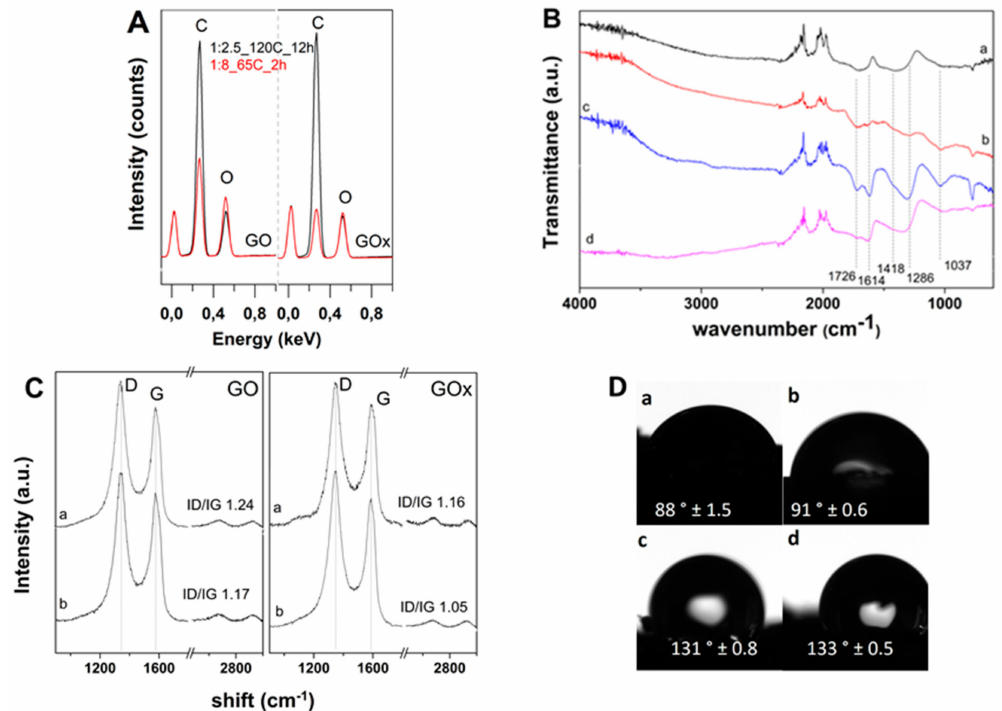
Figure 4. ( A ) EDS spectra of aerogels from GO and GOx dispersions; ( B ) FTIR spectra of aerogels from GO and GOx at 1:8_65 ◦ C_4 h (a and b), GOx at 1:2.5_4 h at 65 ◦ C and 120 ◦ C (c and d); ( C ) Raman spectra of aerogels from GO and GOx at 1:8_65 ◦ C_2 h (a) and 1:2.5_120 ◦ C_12 h (b); ( D ) Average contact angle of GO (left) and GOx (right) aerogels obtained in the conditions: 1:8_65 ◦ C_4 h (a and b), and 1:2.5_120 ◦ C_12